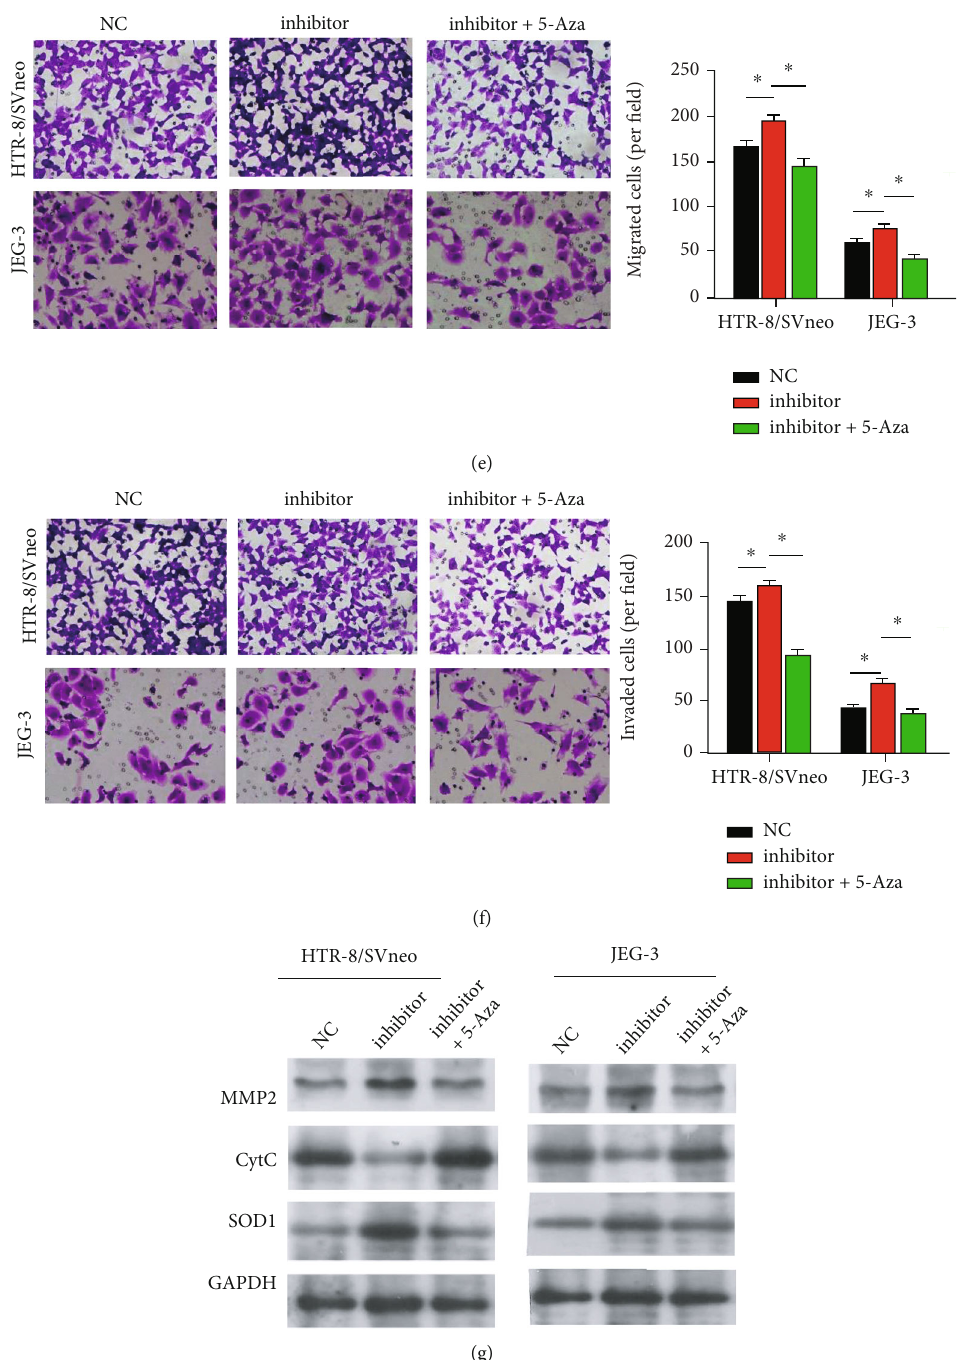
Figure 3: 5-Aza treatment attenuated the e ff ects of miR-155 knockdown on trophoblast dysfunction in vitro . (a) RT-qPCR analysis of miR- 155 indicated that the miR-155 inhibitor-evoked downregulation of miR-155 was reversed by 5-Aza treatment of HTR8/SVneo and JEG-3 cells. (b) 5-Aza inhibited methylation level of miR-155 promoter in HTR8/SVneo and JEG-3 cells. (c) CCK-8 assay indicated that 5-Aza reversed the promotion of cell viability by the miR-155 inhibitor in HTR8/SVneo and JEG-3 cells. (d) Detection of cell apoptosis by TUNEL assay. Transwell assays indicated that 5-Aza attenuated the increased cell migration (e) and invasion (f) induced by the miR-155 inhibitor (magni fi cation 200 × ) in HTR8/SVneo and JEG-3 cells. (g) The protein levels of MMP2, CytC, and SOD1 were measured in 5- Aza-treated HTR8/SVneo and JEG-3 cells with the miR-155 inhibitor. ∗ P < 0 : 05 , ∗∗ P < 0 : 01 , and ∗∗∗ P < 0 : 001 light microscope. The procedure of the invasion assay was similar to the migration assay, except that Transwell inserts with 0.1% crystal violet for 15 min. The number of migratory were precoated with Matrigel (BD Biosciences). cells was counted in three randomly selected fi elds under a